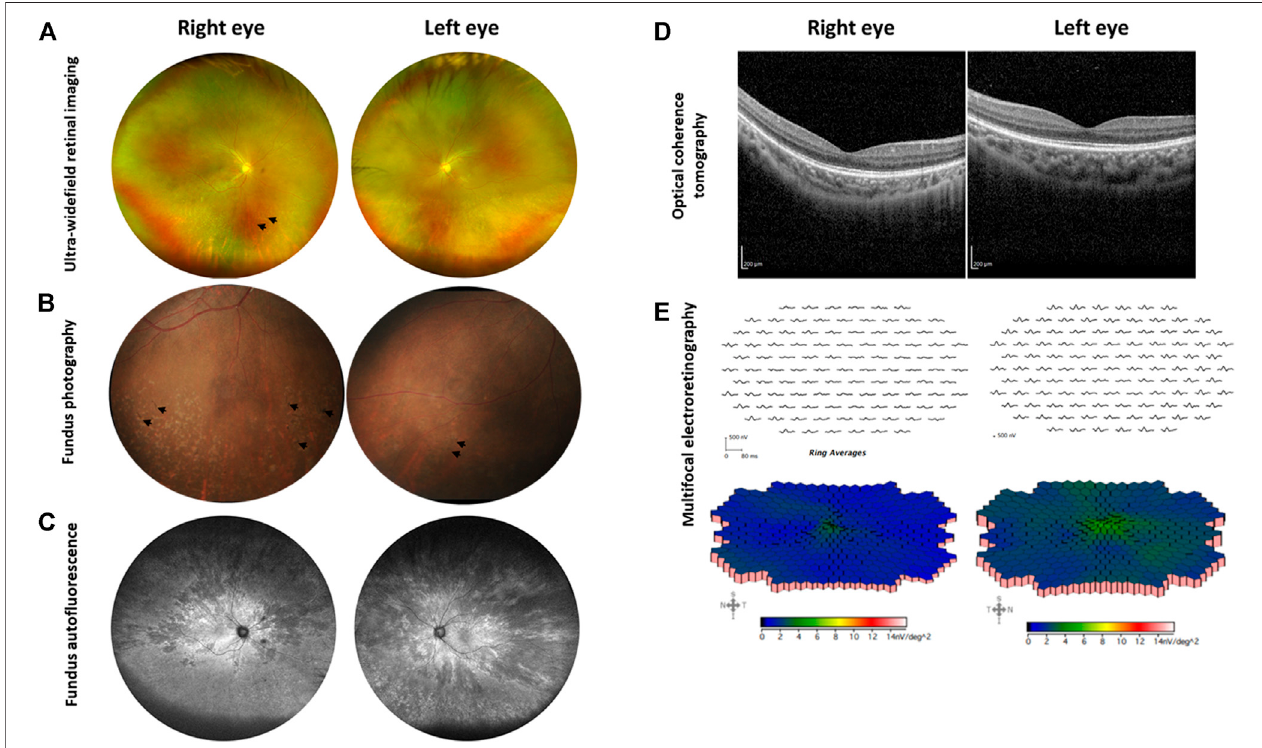
FIGURE 2 | Ophthalmological examination of the XLRP carrier. (A) Ultra-wide fi eld retinal imaging reveals pigmentary changes in the right eye as indicated by arrows, while the left eye shows milder changes. (B) Fundus photography reveals bone spicules in the inferior retina of both eyes, as marked by arrows. (C) Ultra- wide fi eldfundus auto fl uorescence showsmultiple patchy hypo fl uorescent areas distributingfrom themacula totheperipheral retinainboth eyes. (D) Opticalcoherence tomographyrevealspreservedcentral fovealellipsoid zones, withattenuation intheperifoveal area. (E) Multifocalelectroretinographyshowsmarkedattenuationof the entire macular area of the retina (right eye) and diagonally patchy appearances of low amplitude responses (left eye). Data were retrieved from the ophthalmological examination at the age of 8